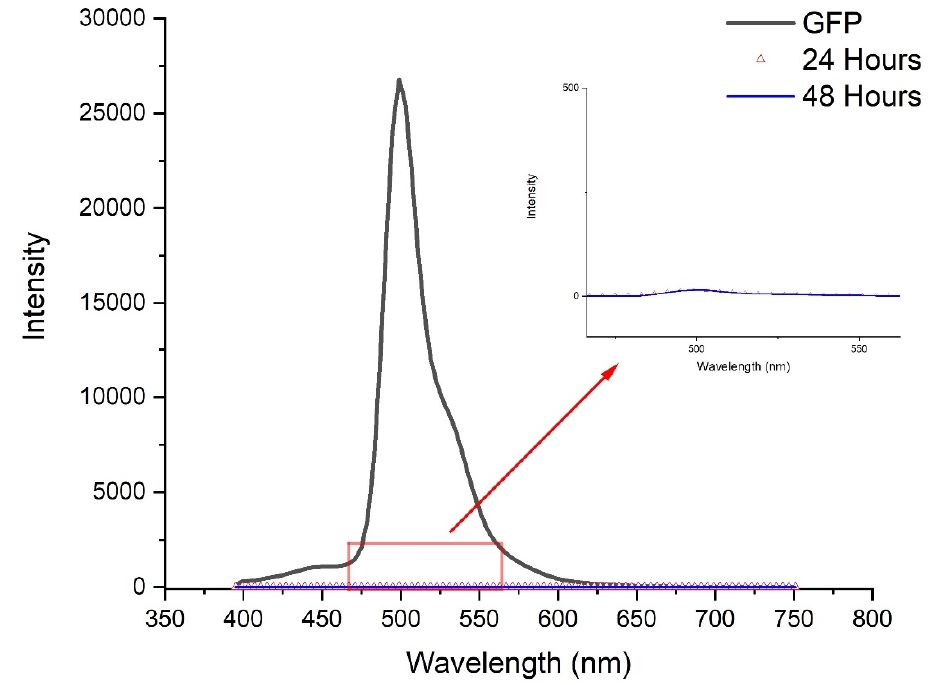
Figure 2. Fluorescence spectra of the dialysis control test. The spectra show no significant amount of green fluorescent protein (GFP) remaining after 24 hours.